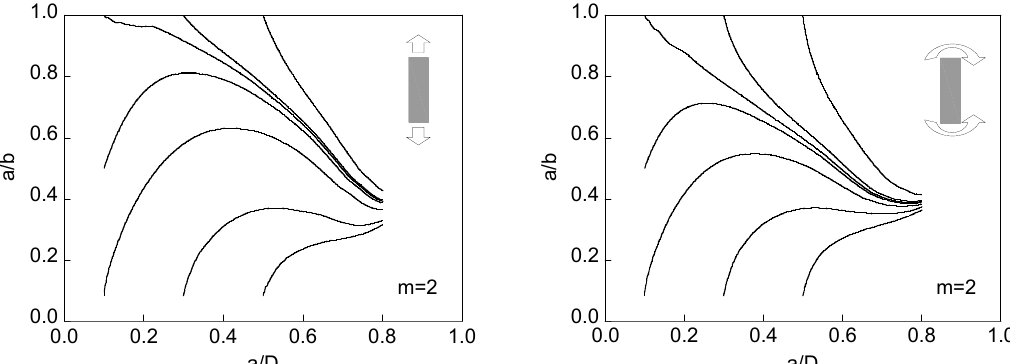
Figure 5: Evolution of the aspect ratio a / b with crack growth (represented by the relative crack depth a / D ) for m =2, starting from different initial crack geometries under tension loading (left) and bending moment (right).